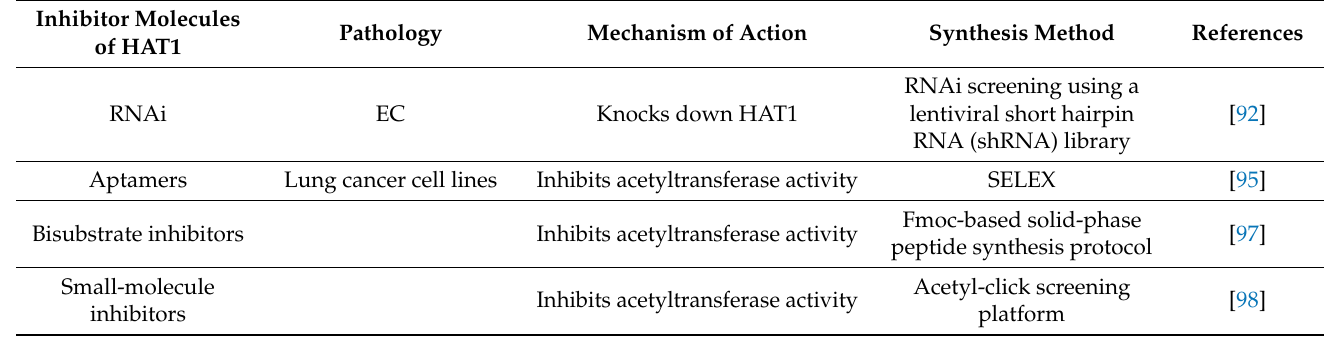
Table 3. Main translational opportunities targeting